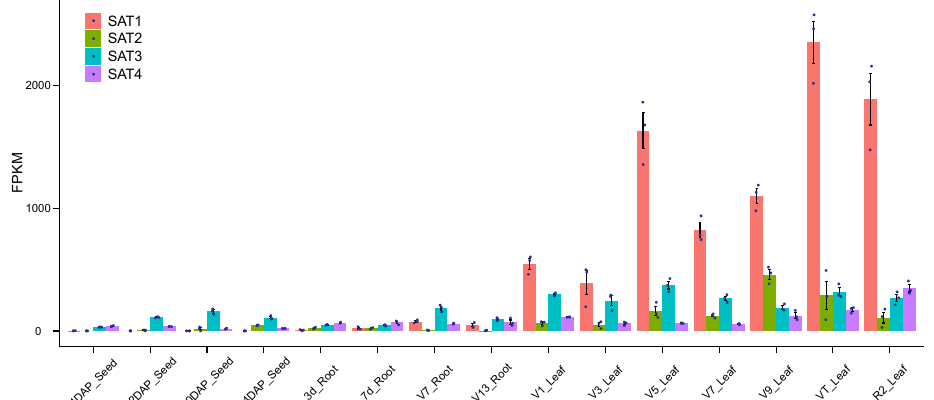
Figure 3. Quantification of SAT gene expression at developmental stages and different tissues in B73. The x -axis shows the sample names and the y -axis exhibits the fragments per kilobase of gene model per million reads mapped (FPKM) value of gene expression. The growth stages are represented by day after pollination (DAP), collar of 1st leaf visible (V1), collar of 3rd leaf visible (V3), collar of 5th leaf visible (V5), collar of 7th leaf visible (V7), collar of 9th leaf visible (V9), VT Tassel (all branches visible, no silks) and R2 (kernels are watery blisters with clear fluid). The raw data were generated by the Kaeppler lab using three biological replicates. The averaged FPKM value was downloaded from the paper of Stelpflug et al. [16] with standard errors.